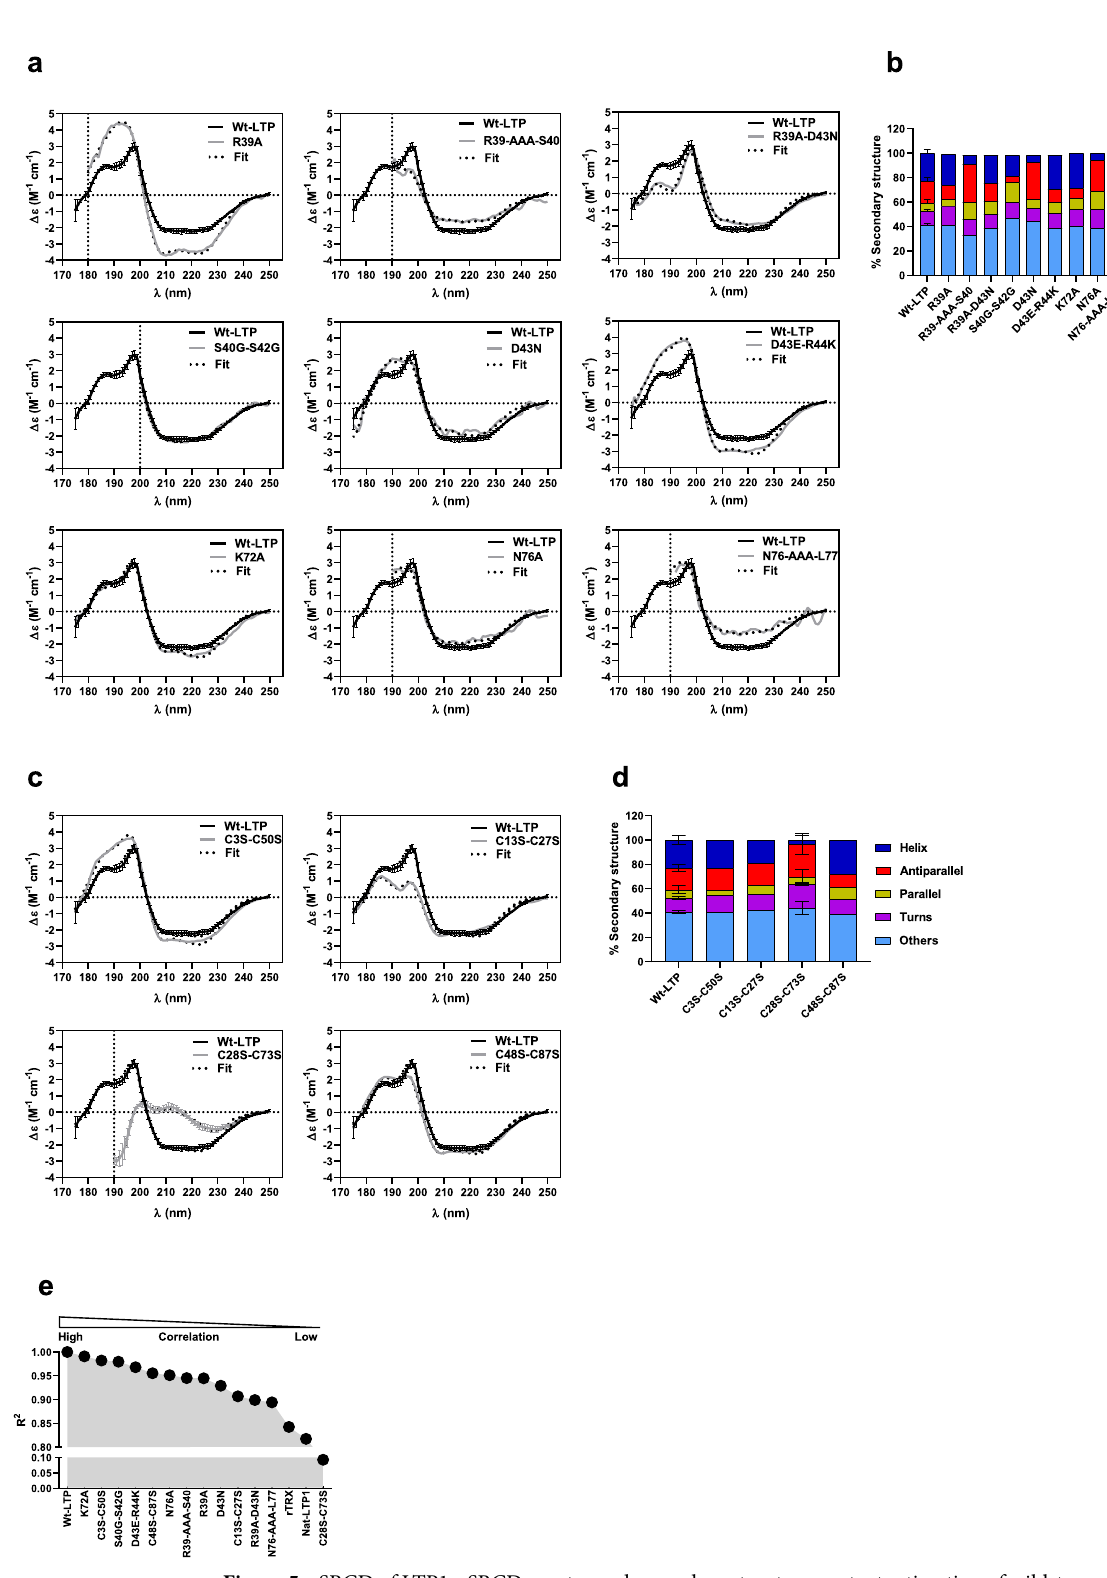
Figure 5. SRCD of LTP1s. SRCD spectra and secondary structure content estimation of wild-type and LTP1 variant proteins. The fit corresponds to the theoretical curve used for secondary structure calculation. ( a ) Spectra for variants affecting sequence conservation or protein flexibility. ( b ) Corresponding bar plot indicating secondary structure content. ( c ) Spectra for variants affecting disulfide bonds. ( d ) Corresponding bar plot indicating secondary structure content. ( e ) Pearson correlation between the Wt-LTP CD signal and those of the different LTP1 variants. The variants are classified according to the square of the correlation coefficient (R 2 ) from highest to lowest. LTP: lipid transfer protein. SRCD: synchrotron radiation circular dichroism. Wt-LTP: recombinant wild-type wheat